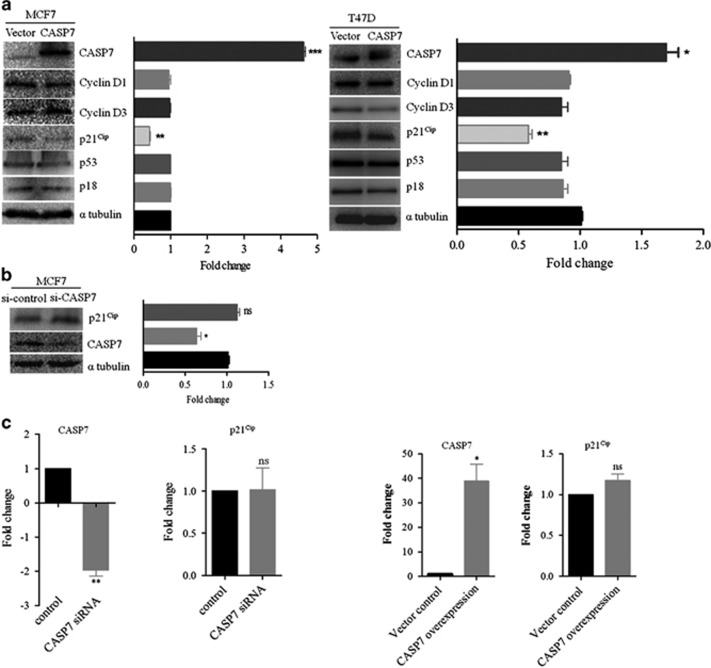
CASP7 targets p21Cip. (a) Western blot of different cell cycle proteins performed after transfecting CASP7 expression vector in MCF7 and T47D cell lines (left panel). Right panel depicts densitometric analyses of the western blot performed in MCF7 and T47D. (b) Western blots performed in whole-cell extract isolated from CASP7 siRNA-transfected MCF7 cells (left panel). Right panel illustrates densitometric analyses of the western blot data. (c) MCF7 cells were transfected with CASP7 siRNA (100 pico mole) and vector expressing CASP7. Forty-eight hours later, the expression levels of CASP7 and p21Cip were evaluated by using quantitative RT–PCR. *P<0.05. **P<0.01. ***P<0.001.